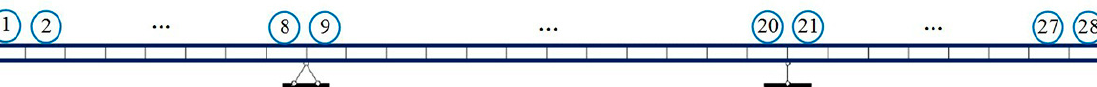
Figure 2. Finite element model of the simply supported beam.